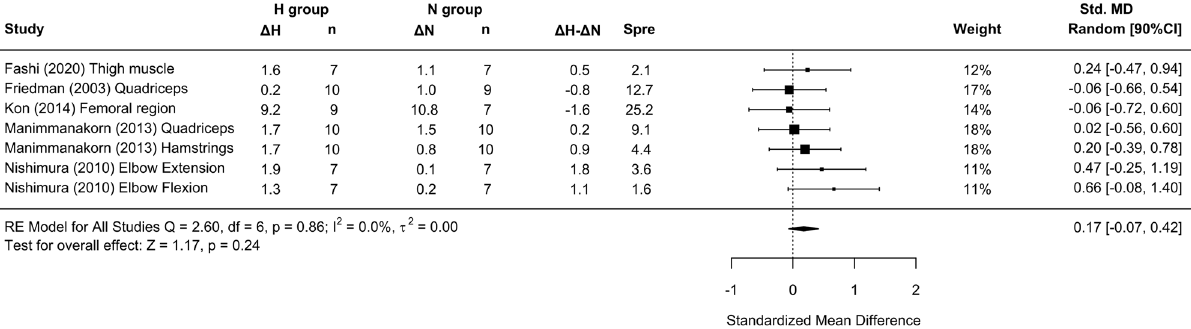
Figure 2. Forest plot of the standardized mean differences of the total effect of the resistance training program between-conditions (hypoxic [H] group vs. normoxic [N] group) on CSA. Δ: mean differences between post– pre in H and N or between H–N; n: sample size; Spre: mean baseline standard deviation; Std. MD: standard mean difference; RE: random effect’s model; CI; confidence interval; Q: test statistic for the test of heterogeneity; df: degrees of freedom; p : p value; I 2 : I 2 test; τ 2 : tau 2 test; Z: z